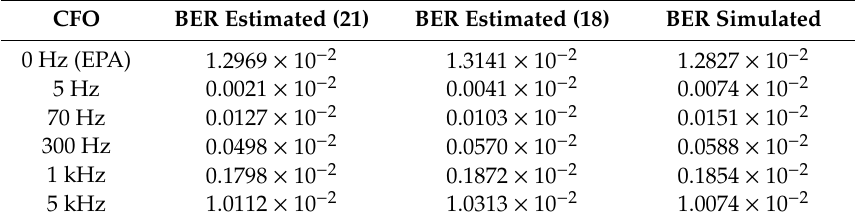
Table 8. Time dispersion abstracted CFO-exclusive BER penalties; 16 QAM, EPA